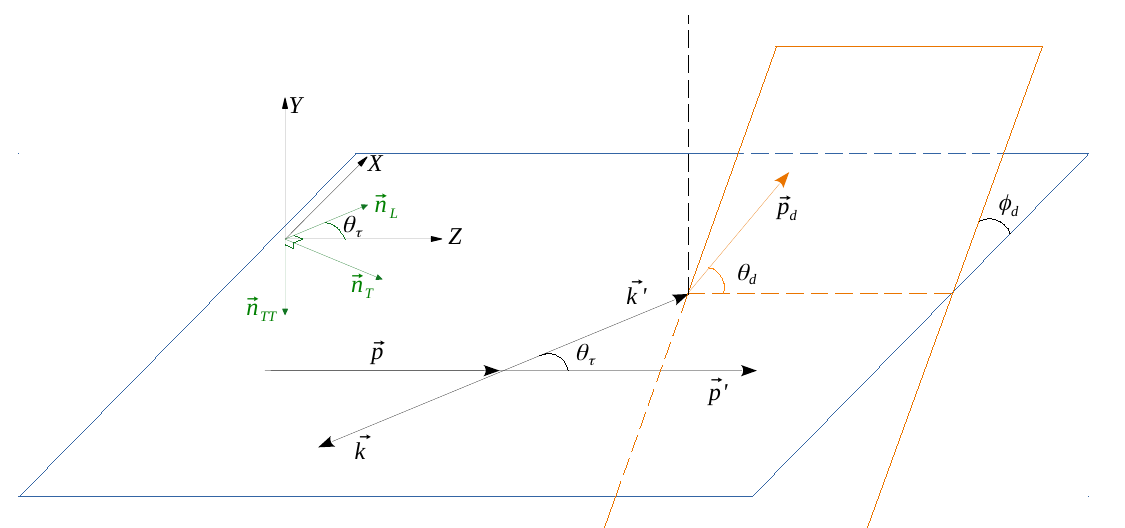
Figure 1 . Kinematics in the τ ¯ ν τ CM reference system associated with eq. (1.2), and used in ref. [69]. The initial and final hadron three-momenta are ~p and ~p 0 , respectively, with ~q = ~p − ~p 0 = ~ 0 , while ~k 0 and ~k are those of the intermediate τ and outgoing ¯ ν τ emerging from the primary CC transition ( ~q = ~k + ~k 0 = ~ 0 ). In addition, ~p d is the momentum of the tau-decay massive product ( µ, π or ρ ). We also show the unit vectors ( ~n L ,~n T and ~n TT ) which define the three independent projections of the τ − polarization vector (see ref.